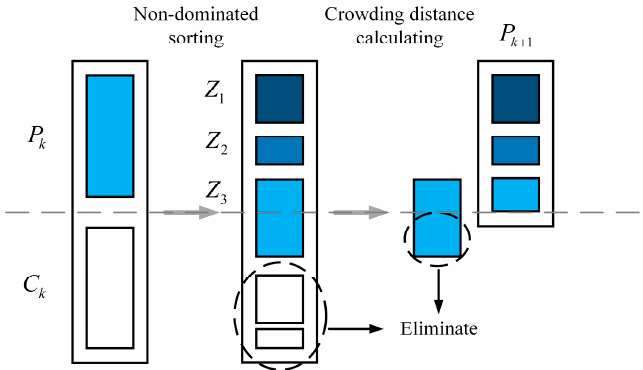
Figure 4. The flowchart of the proposed IMNSGA-II.